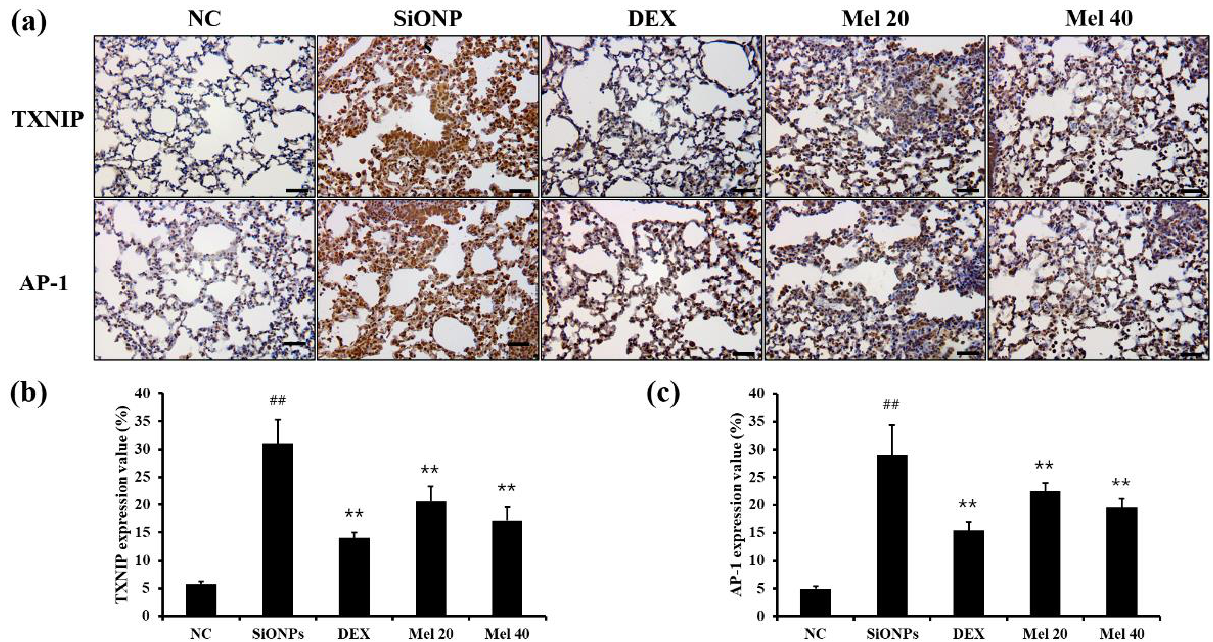
Figure 5. Melatonin suppressed the expression of TXNIP and AP-1 in the respiratory tract of SiONPs-exposed mice. ( a – c ) IHC was performed to measure the expression of TXNIP (1:200) and AP-1 (1:200). Quantitative analysis of each protein expression was conducted using image analyser (IMT i- Solution) (×200). Scale bars = 50 μm. ## p < 0.01, vs. the NC; ** p < 0.01, vs. the SiONPs.